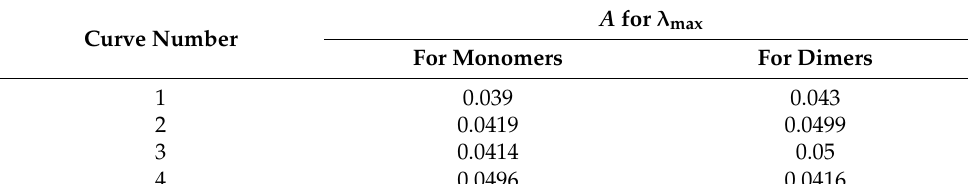
Figure 12. An example of decomposition of Curve 1 on Figure 11 in two components ( 2 and 3 ).